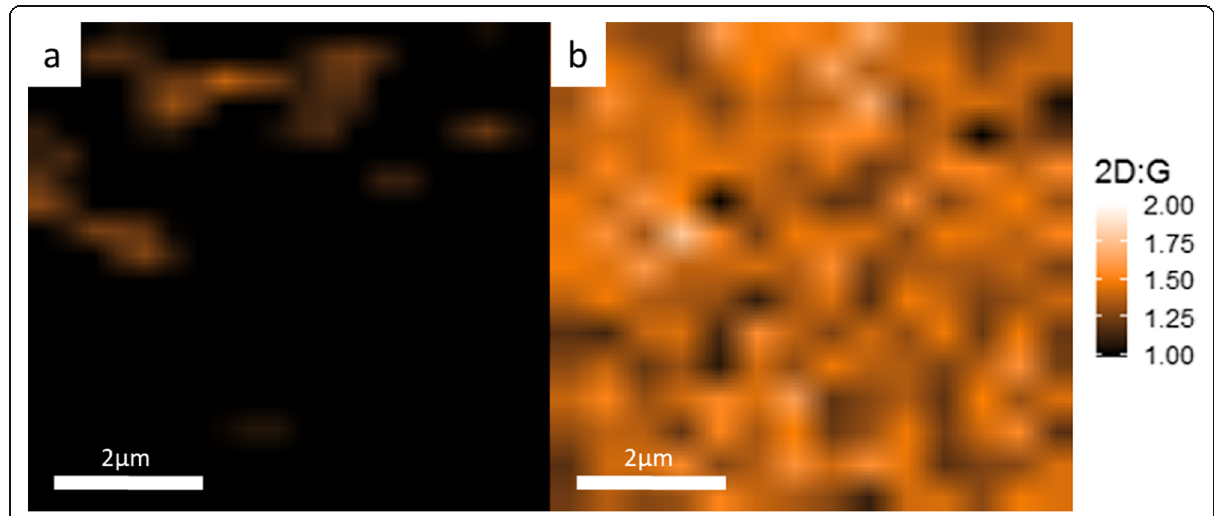
Fig. 7 Raman maps showing I 2D:G > 1.0 for a CVD synthesis with 7 min exposure time versus b 10 W ICPCVD synthesis with 30s exposure time. Both growths are 450 °C on codeposited Ni-Au catalyst. The addition of plasma increases layer uniformity from 11.6% ( a ) to 99% ( b